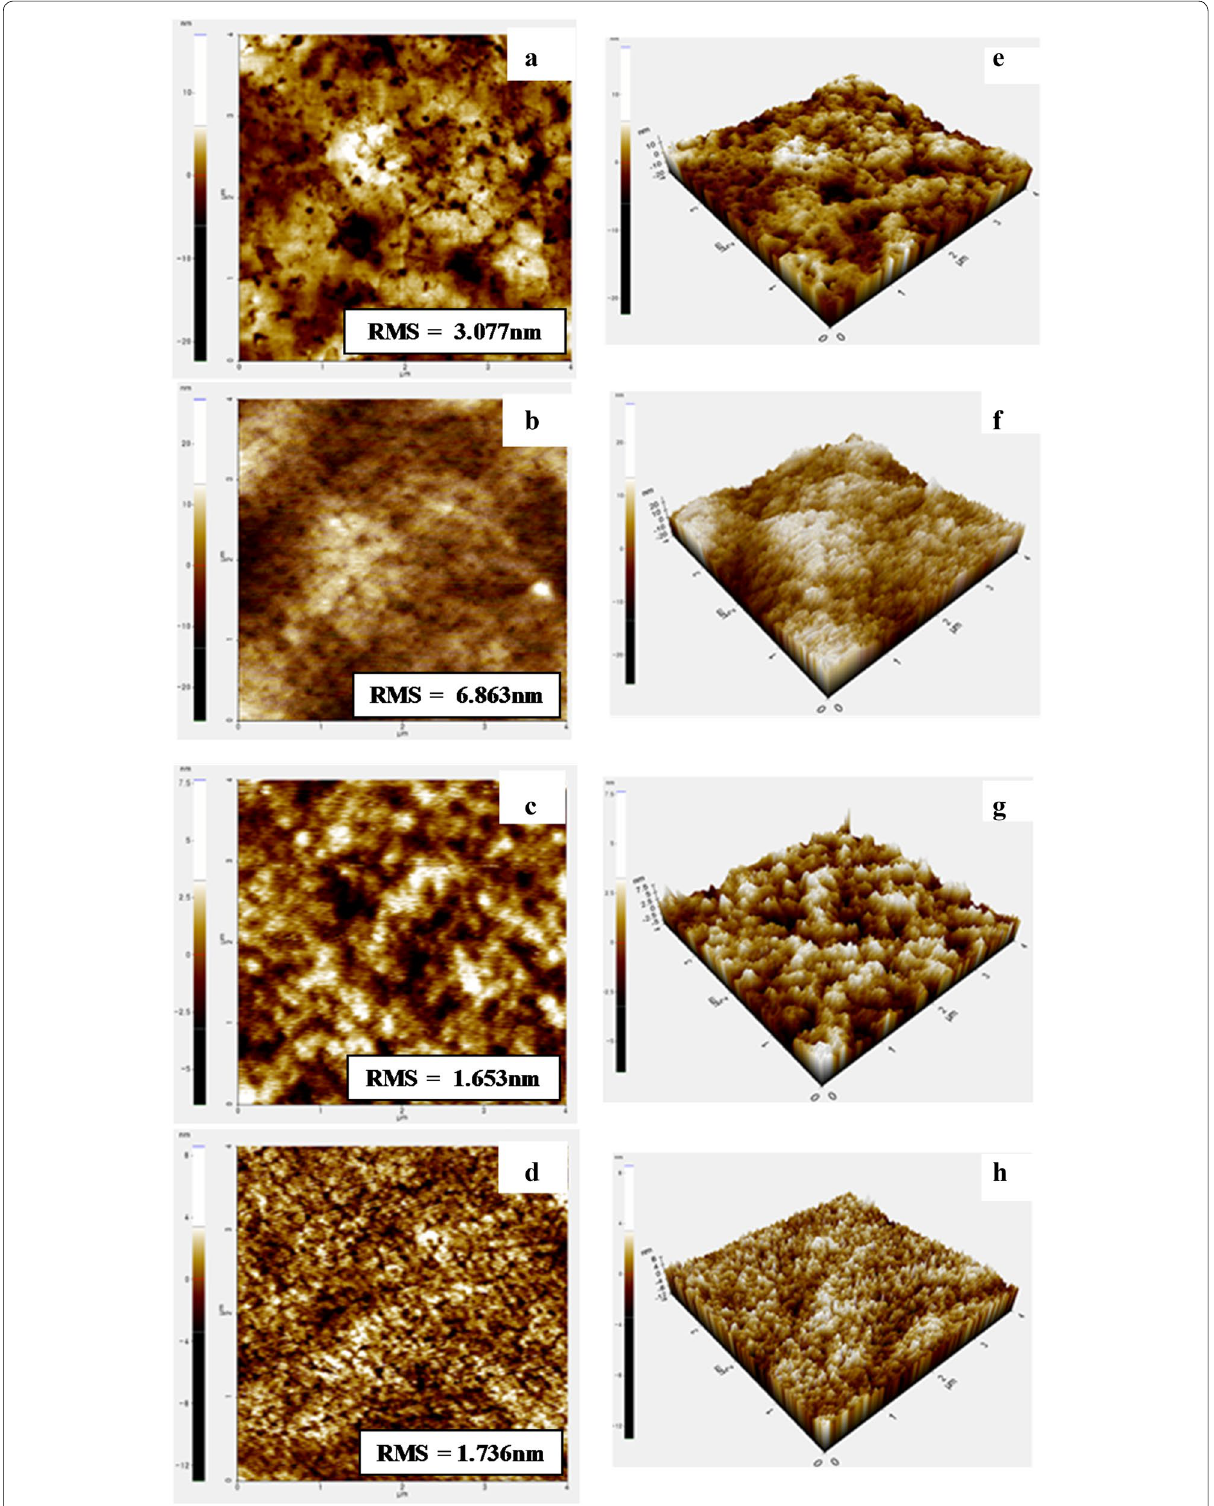
Fig. 3 Non‑contact mode AFM 2D height images of BHJ films based on a – c in CB–DIO3% solvent and d in CB–CN3% solvent, a P‑IDI‑SVS(CB):PC 70 BM, b P‑IDI‑SVS(CF):PC 70 BM, c , d P‑IDI‑SVS(THF):PC 70 BM. Non‑contact mode AFM 3D height images of BHJ films based on based on e – g in CB–DIO3% solvent and h in CB–CN3% solvent, e P‑IDI‑SVS(CB):PC 70 BM, f P‑IDI‑SVS(CF):PC 70 BM, and g , h P‑IDI‑SVS (THF):PC 70